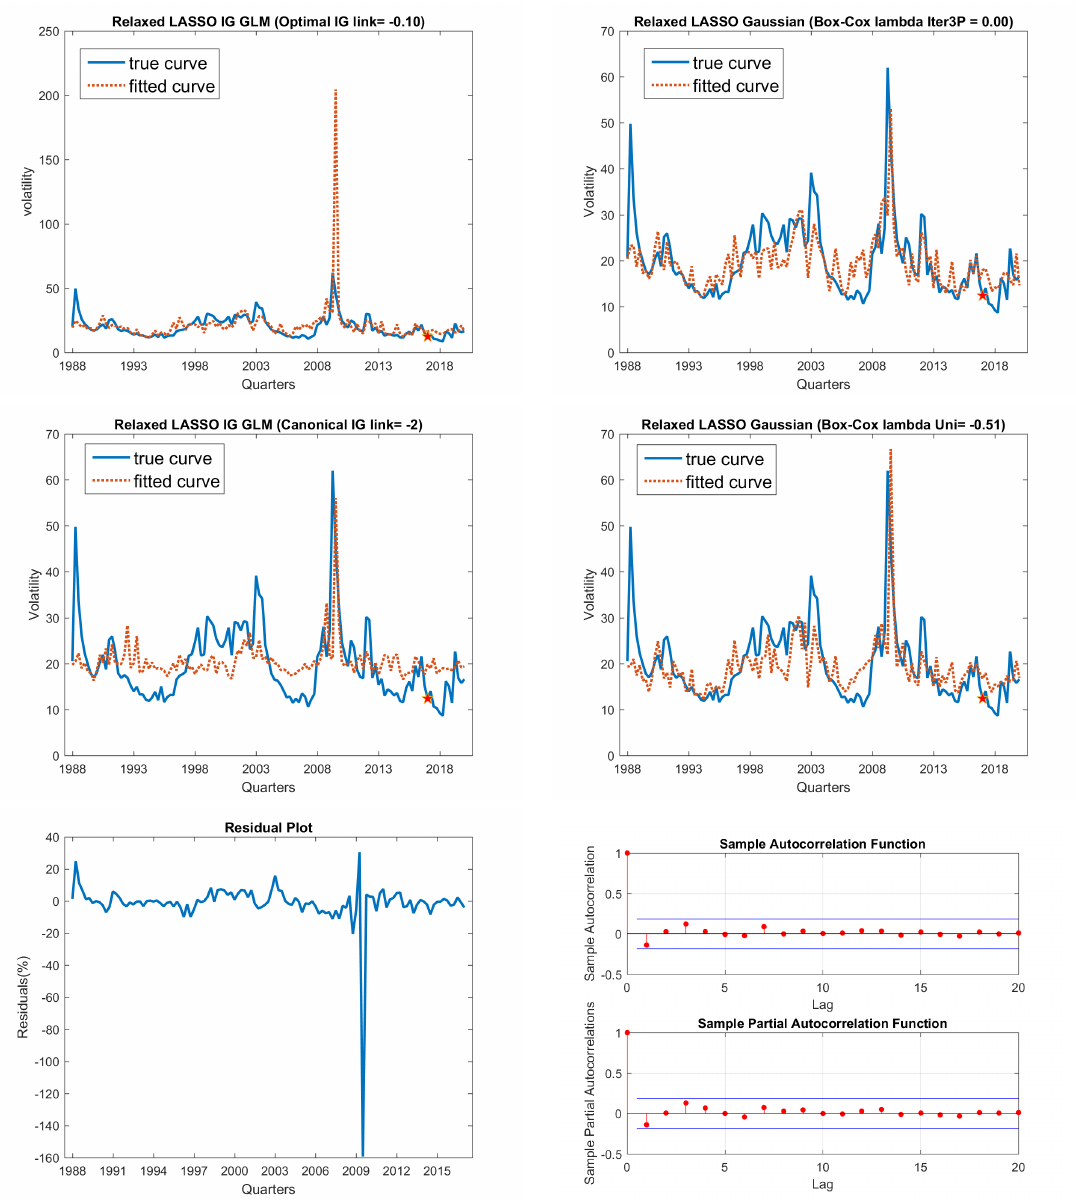
Figure 7. Significant covariates fitted curve in comparison with true curve: VXO on macroeconomic data data. 1. ( Top-left panel ) is optimal link IG model; ( top-right panel ) is three-phase iteratively searched λ BC Gaussian model; 2. ( Middle-left panel ) is canonical link IG model; and ( middle-right panel ) is univariate λ BC Gaussian model; 3. ( Bottom-left panel ) is plot of residuals from best fitting model (optimal link IG model here); ( bottom-right panel ) is ACF and PACF plots to perform residuals serial correlation check, which shows no serial